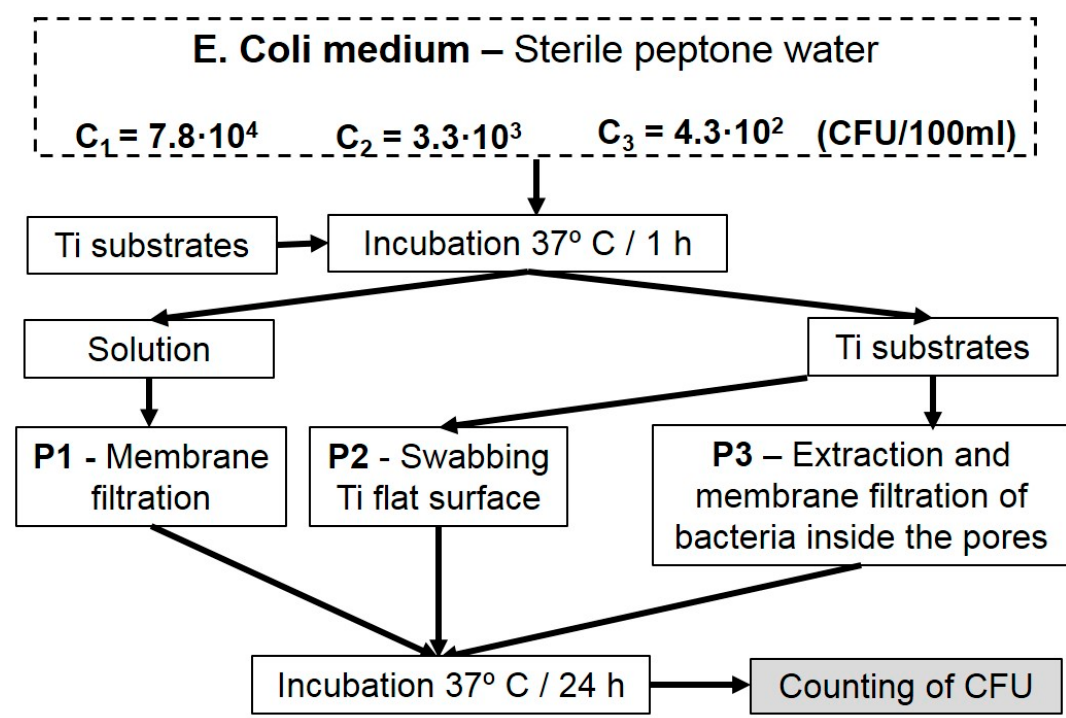
Figure 1. Analytical procedures employed to E. coli bacteria analyses.